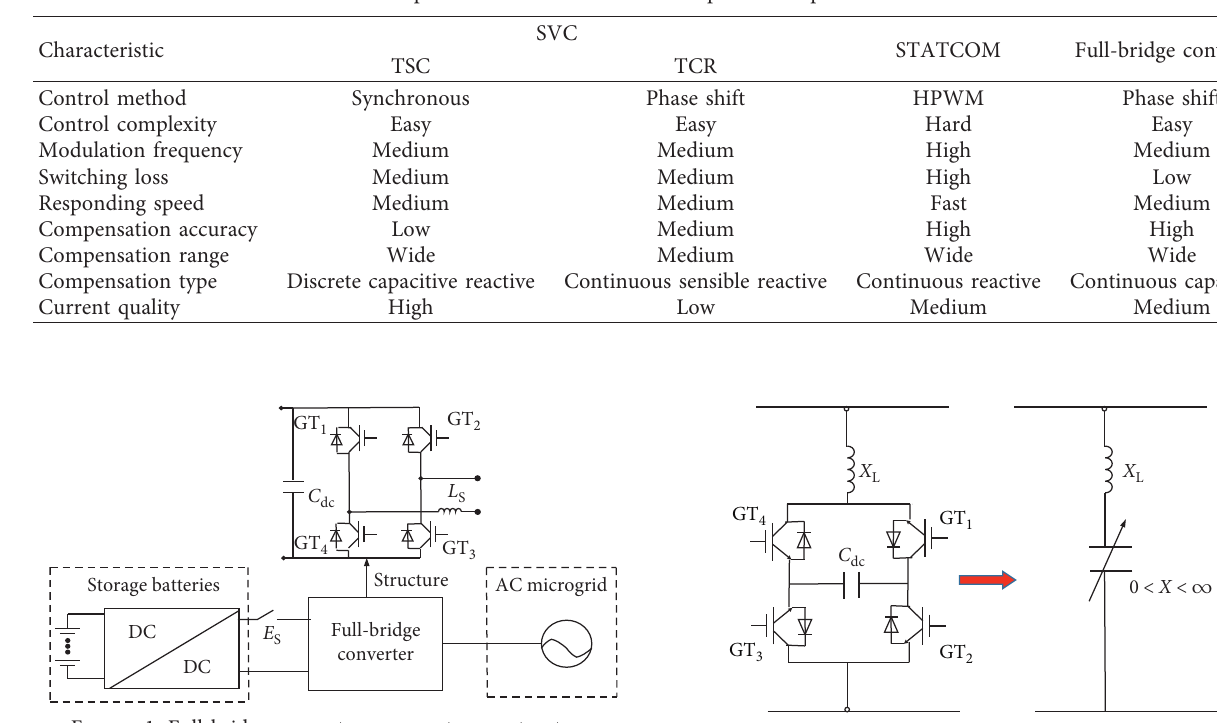
Table 1: Comparison of mainstream reactive power compensator characteristics.